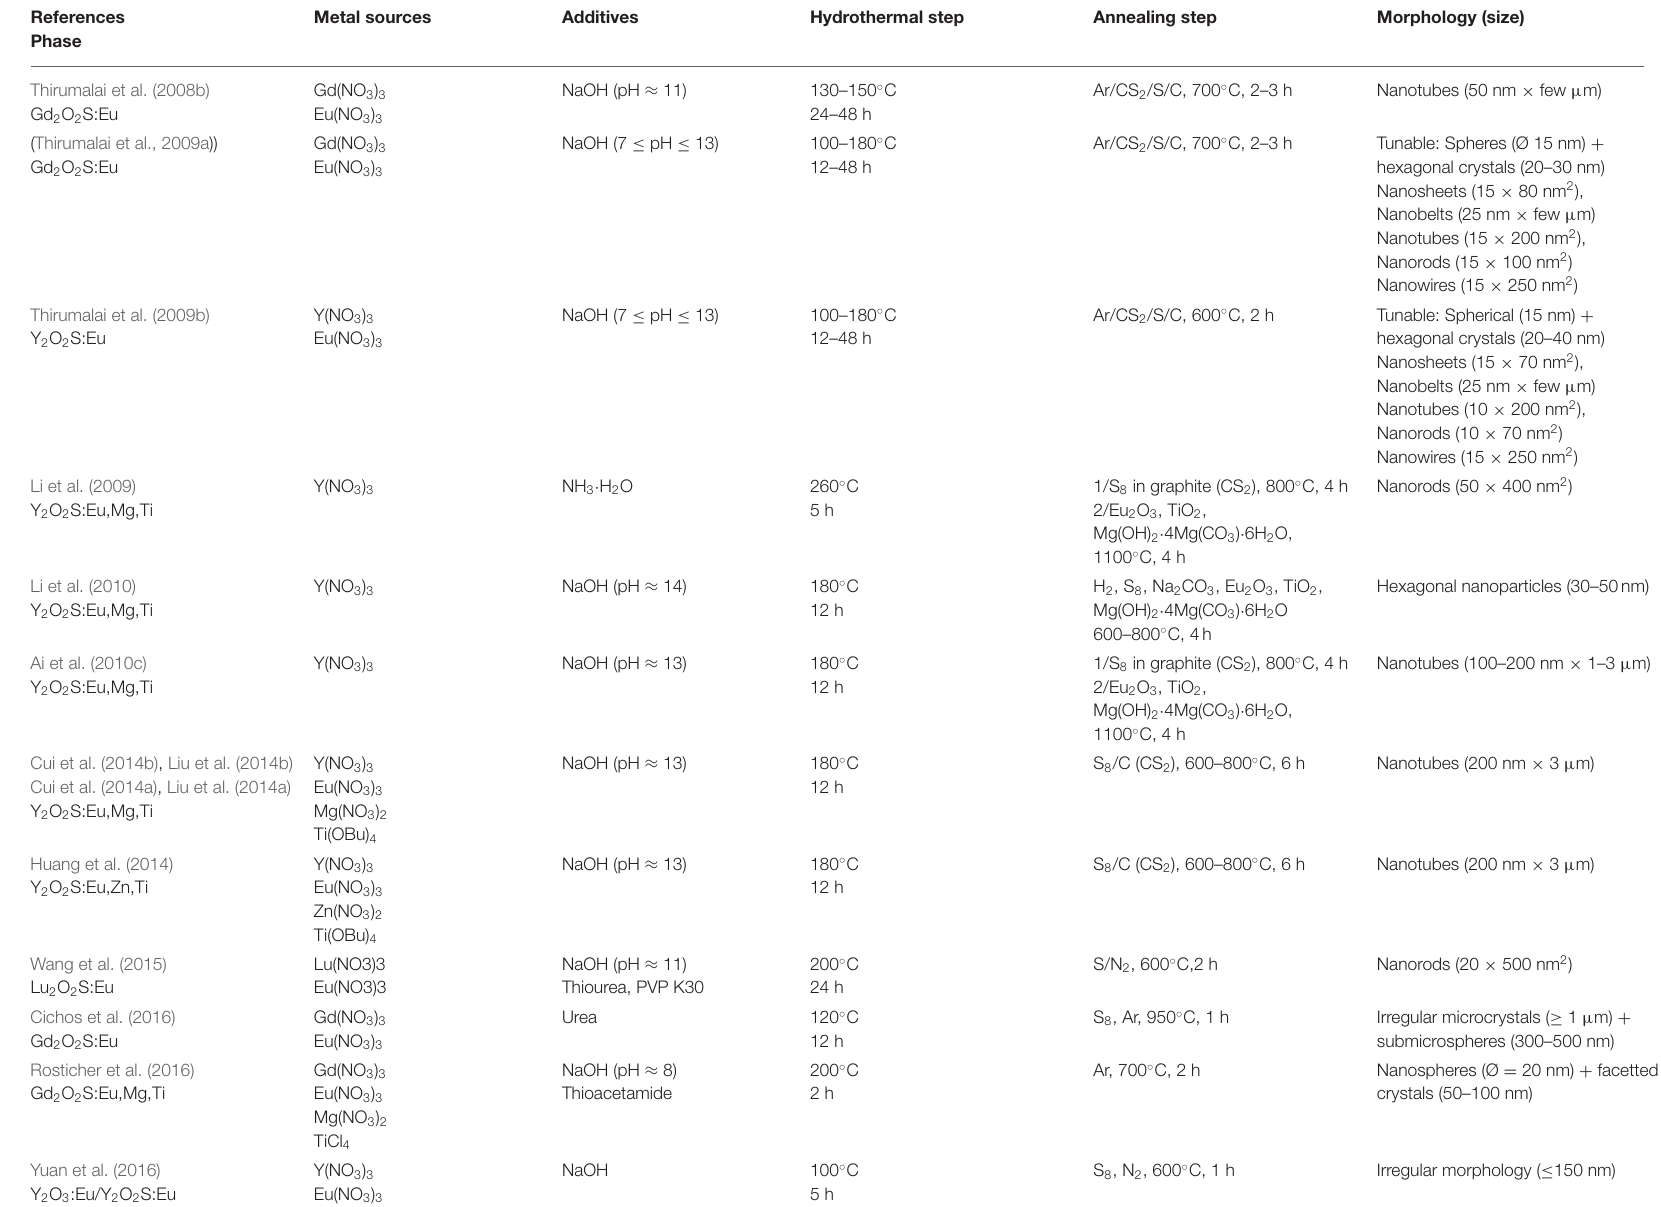
TABLE 4 | Hydrothermal syntheses of Ln 2 O 2 S